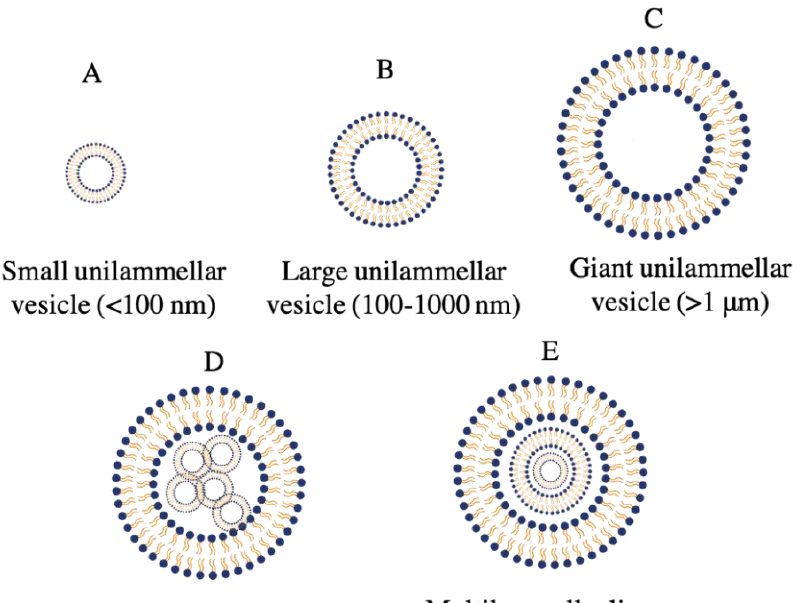
Figure 3. Classification of liposomes based on their lipid bilayer structure and size. ( A ) Small Unilammelar Vesicles (SUV), ( B ) Large Unilammelar Vesicles (LUV), ( C ) Giant Unilammelar Vesicles (GULV), ( D ) Multivesicular Liposome, ( E ) Multilammelar Liposome